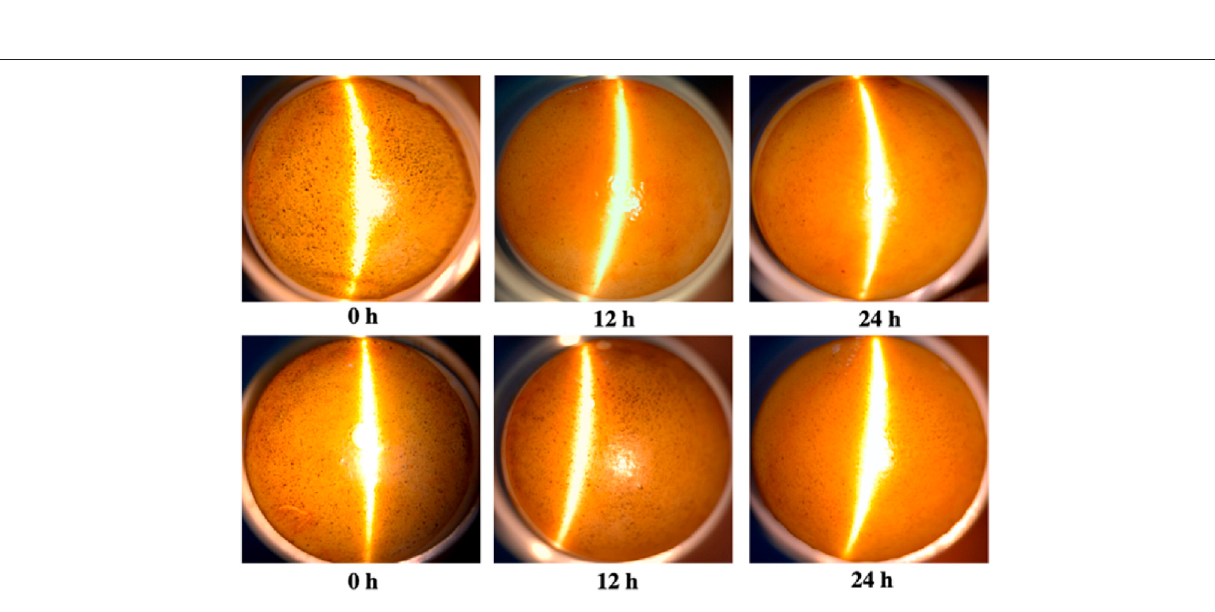
Frontiers in Bioengineering and Biotechnology |